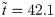
Test 3: Comparison between FOM and DL-ROM solutions for a testing-parameter instance at different time instances.FOM solution (left) and DL-ROM one (right), with n = 10, at t˜=42.1 ms (top) and t˜=276 ms (bottom), for the testing-parameter instance μtest = 12.9 ⋅ 0.3243 mm2/ms.